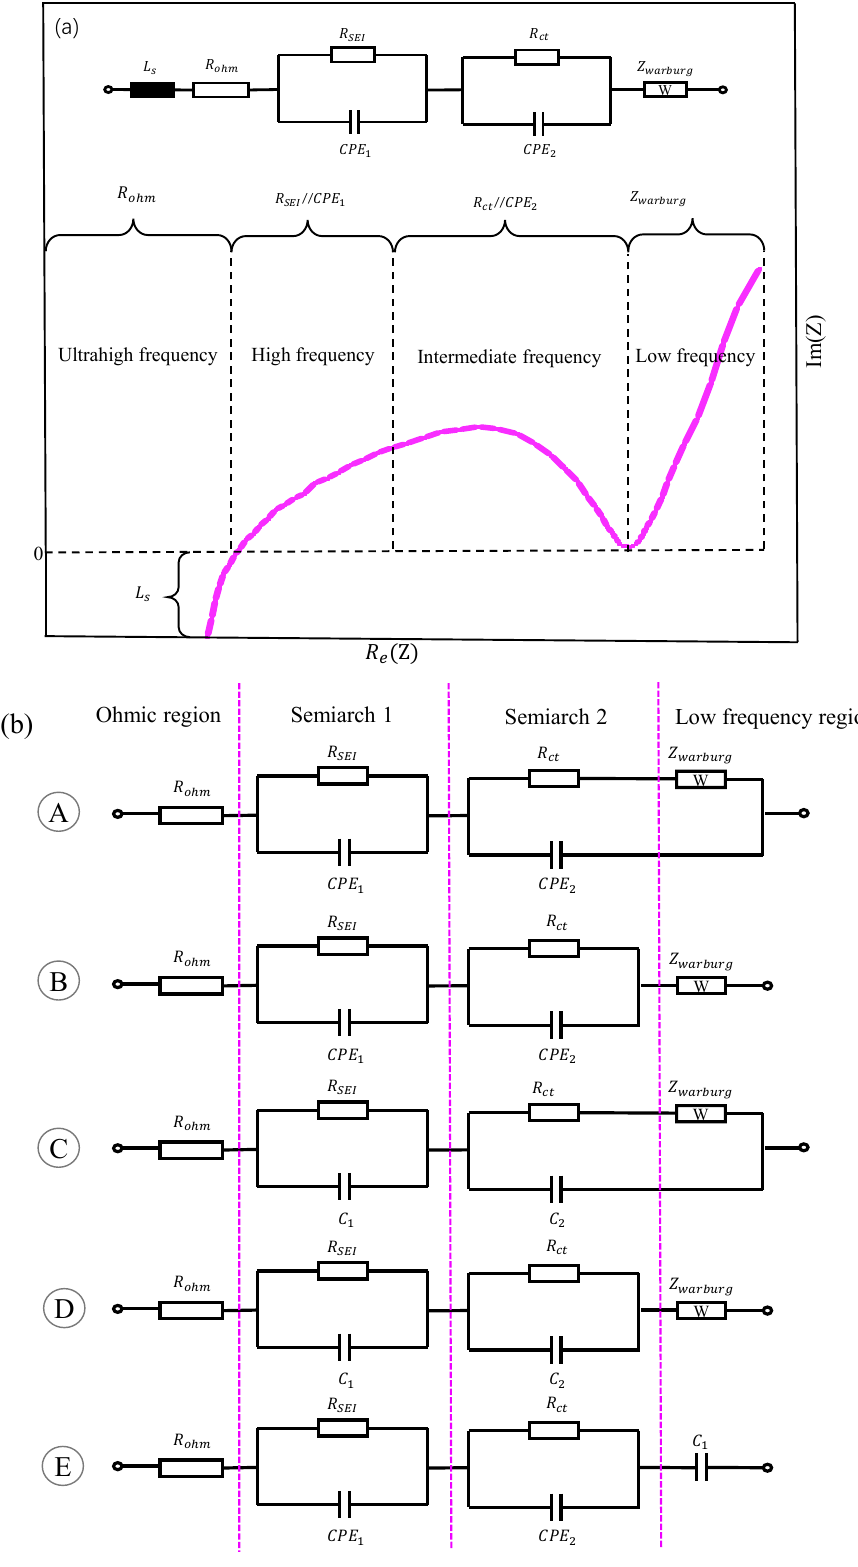
Figure 5. ECM of LIBs ( a ) EIS curves and their corresponding ECM elements. ( b ) The different ECM models of LIBs.